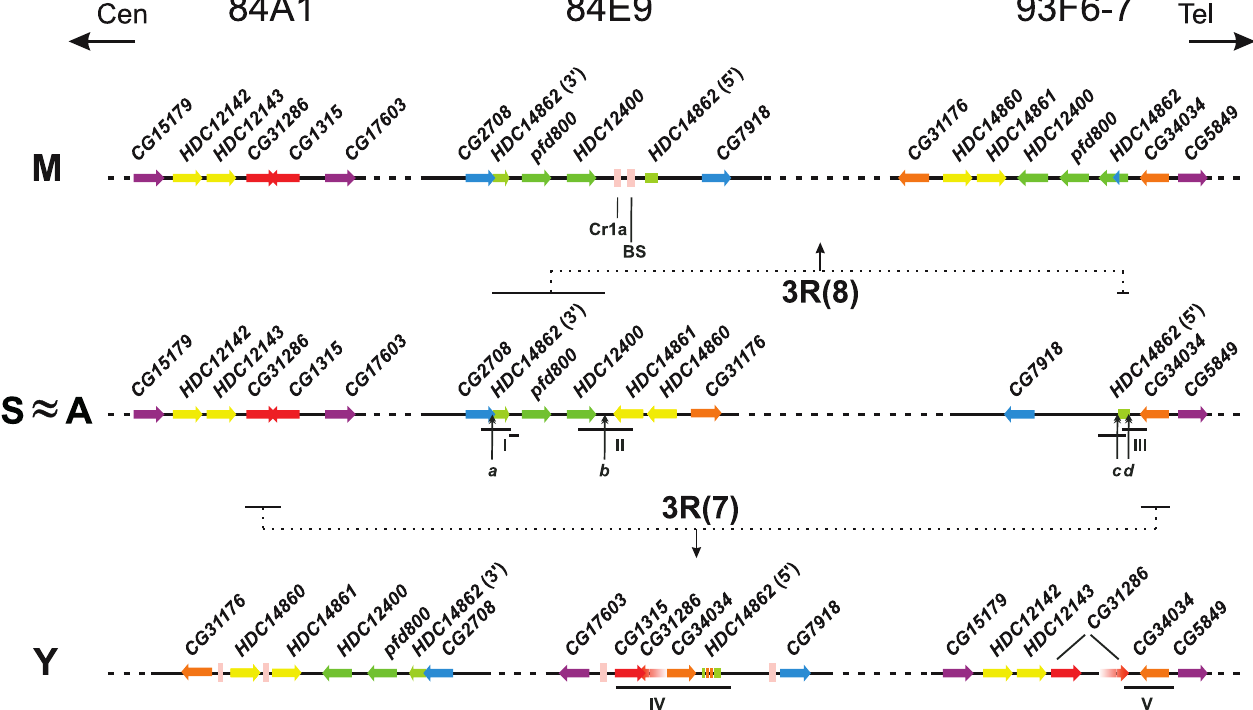
Figure 1. Molecular Organization of Three Genomic Regions of the Right Arm of Chromosome 3 in D. melanogaster, D. yakuba, and in D. simulans These three genomic regions harbor the breakpoints of the paracentric inversions 3R(7) and 3R(8), also known as In(3R)84F1;93F6–7, and have been reconstructed by BLAST analysis, in situ hybridization, resequencing, and whole-genome alignments at UCSC (http://genome.ucsc.edu/). According to the information in D. erecta and different outgroup species (Table 1), D. simulans (S) is the species that best represents the ancestral (A) configuration for all three regions. Reference genes at the different breakpoint regions have been colored red, blue, and orange. Between some of the reference genes, putatively expressed genes (green and yellow; [60]) and repetitive sequences (pink) are also present. Other surrounding genes are indicated in brown. Top, cytological coordinates of the regions in D. melanogaster (M). Long horizontal lines indicate chromosomes; solid pattern indicates key region; and dashed pattern indicates chromosomal stretch separating key regions. Cen, centromere; Tel, telomere. The head of each colored horizontal arrow represents the 3 9 end of each gene or putative gene. Chromosomal segments included in the inversion 3R(7) and 3R(8) are indicated by dotted lines. For both inversions, the sequences between paired staggered breakpoints are indicated by short horizontal solid lines. Roman numerals indicate different chromosomal stretches spanning inversion breakpoints that were sequenced as a control. Vertical arrows indicate the localization in the ancestor (D. simulans) of the four breakpoints (a, b, c, and d) that are necessary to explain the inversion 3R(8) and the duplication of HDC14862, pfd800, and HDC12400 at 84E9 (3R:3862326–3867817; 3R:3874931–3876653) and 93F6–7 (3R:17554739–17562483) of D. melanogaster (see Figure 2). The gene configuration CG7918-CG34034-CG5849 has been disrupted independently in the lineages of D. melanogaster and D. yakuba (Y) by the inversions 3R(8) and 3R(7), respectively. In D. melanogaster, the gene pair CG2708 (Tom34)-CG31176 is also disrupted, whereas in D. yakuba, CG31286-CG1315 is disrupted. Inversion 3R(8) and its associated duplication event generate an apparently full copy of the putative expressed gene HDC14862 in 3R:93E10- F2 of D. melanogaster. This contains 56–59 bp from the 3 9 UTR of the gene CG2708 (blue triangle) within one of its putative introns. HDC14862 is present as two different fragments both in D. simulans and D. yakuba (see main text for details). Further, the inversion 3R(7) has disrupted the antisense overlap of CG31286 and CG1315 in D. yakuba: the antisense configuration is conserved at 84A1 of D. melanogaster and D. simulans, as well as in other species (Table 1). Inversion 3R(7) was accompanied by a duplication of CG34034 and a complex pattern of rearrangement that also involved a fragment of the 5 9 region of HDC14862 . The two open reading frames (ORFs) of CG34034 are functional according to GENSCAN (http://genes.mit.edu/GENSCAN.html), although the putative protein sequences they encode differ substantially from that of their orthologs in D. melanogaster and D. erecta . Some stretches with significant homology with CG31286 are also detected adjacent to CG1315 in D. yakuba . The reference gene CG31286 is also tandemly duplicated and adjacent to CG34034 . In D. yakuba, there are three copies of CG31286, two of them being pseudogenes (denoted as a red gradient). Only the copy immediately distal to HDC12143 is functional, although it apparently codes for only one of the two isoforms of its D. melanogaster ortholog. Genes and distances between them are not represented proportionally. inversion were between the protein-coding genes CG2708 and CG7918, proximally, and CG31176 and CG34034, distally. The gene pairs CG2708-CG7918 and CG31176-CG34034 delimit two breakpoint regions in D. melanogaster of 22.6 and 17.8 kilobases (kb) long at 84E9–10 and 93E10-F2, respectively (Figure 1). Neither region contains any annotated protein- coding genes in the Drosophila genome Release 4.3 annotation (http://chervil.bio.indiana.edu:7092/annot/), with only the non-LTR retrotransposons BS and Cr1a in the region at 84E9–10 as identifiable features [59]. We further character-